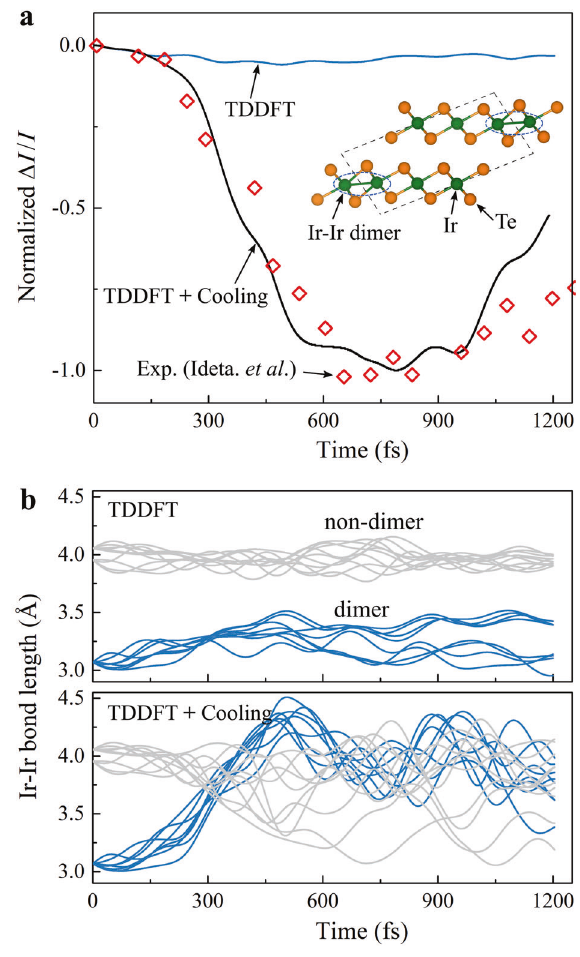
Fig. 1 Evolution of diffraction intensity and bond length. a Simulated PLD diffraction intensity I ( t ) is obtained through the Debye – Waller formula 40 – 42 , I ( t ) = exp[ − Q 2 < u 2 ( t )>/3], where Q is the magnitude of the reciprocal lattice vector for the re fl ection probed, and u 2 ( t ) is average mean-square atomic displacements, as shown in Supplementary Fig. 1. Red diamonds show relative diffracted intensity changes ( Δ I / I ) measured by FED experiments 7 . Note that the zero-point time in the experiment is labeled after photoexcita- tion so that the diffracted intensity is far less than 0 at t = 0 fs. We reinstall the experimental data at t = − 380 fs in ref. 7 as zero-point time in our work, giving a maximum value of the diffracted intensity at t = 0 fs. Blue and black lines represent the photoinduced lattice dynamics without and with the carrier cooling effect, respectively. The inset shows the LT phase with Ir – Ir dimerized q = (1/5, 0, 1/5) lattice modulation 27,28,43 . The black dashed box represents the unit cell. b The top (bottom) panel shows the evolution of eight-pair Ir – Ir dimers (blue lines) and ten non-dimerized Ir – Ir pairs (gray lines) in the TDDFT simulation without (with) the carrier